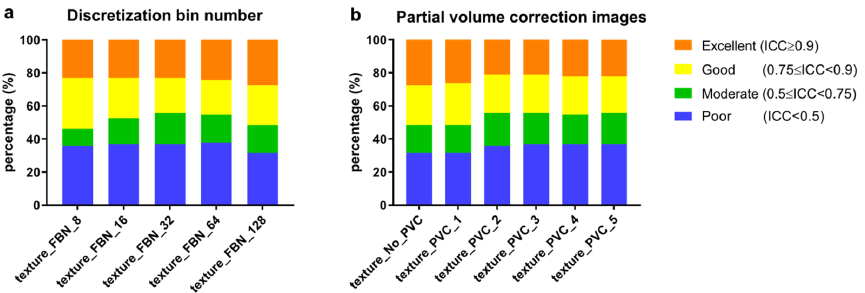
Figure 8. Agreement of texture features between different aggregations methods from: ( a ) original SUV image discretized with FBN from 8 to 128, and ( b ) original SUV and PVC images (with FWHM from 1 to 5) discretized with FBN = 128. The relative distribution of the overall ICC value of texture features per ICC category are shown (ICC > 0.9: excellent, 0.75 ≤ ICC < 0.9: good, 0.5 ≤ ICC < 0.75: moderate, ICC < 0.5: poor).